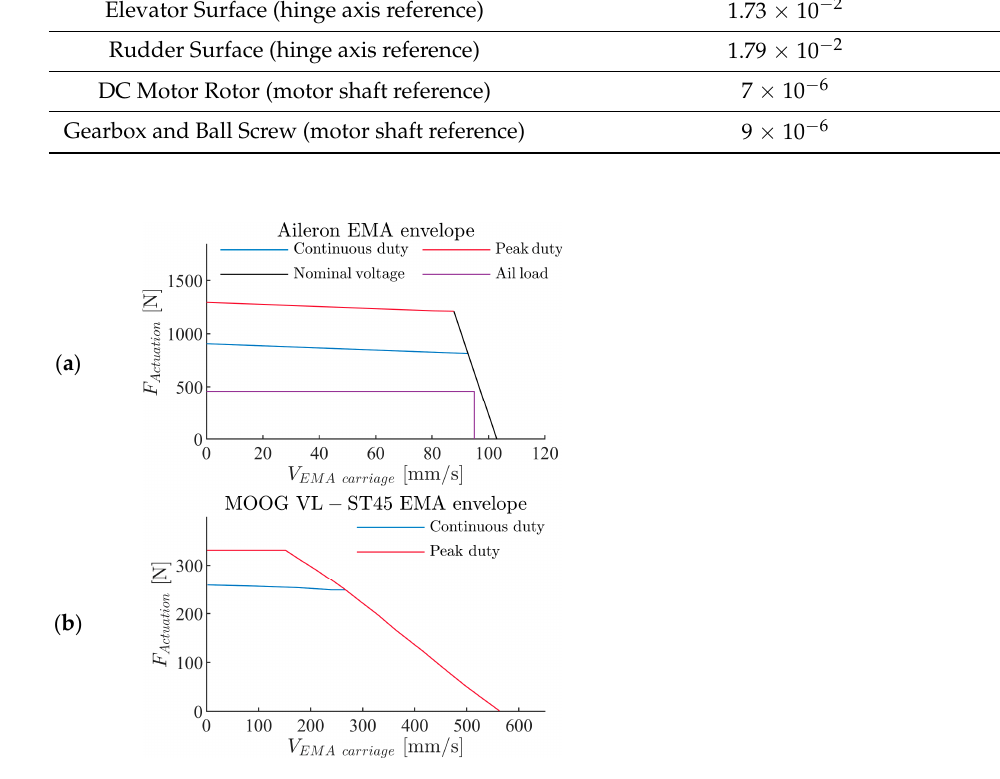
Figure 12. ( a ) Performance envelope of the aileron EMA and the hinge moment load requirement; ( b ) performance envelope of the MOOG VL-ST45 EMA product.